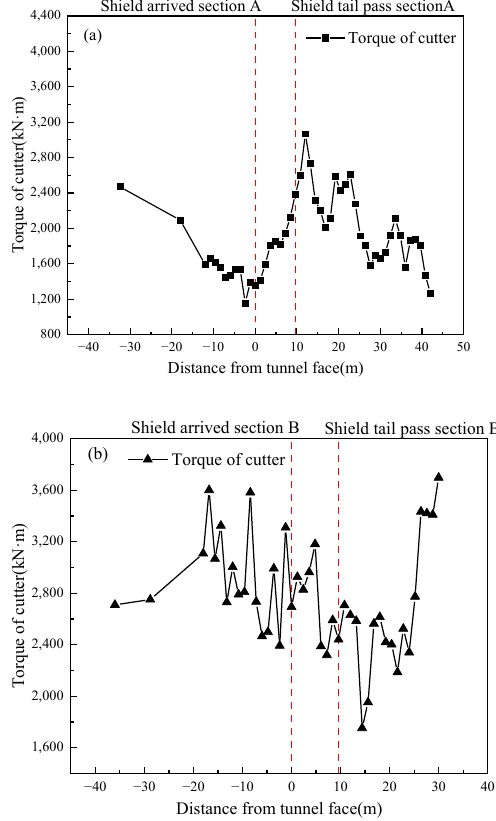
Figure 14. Measured value of torque of cutter: ( a ) south line; ( b ) north line.